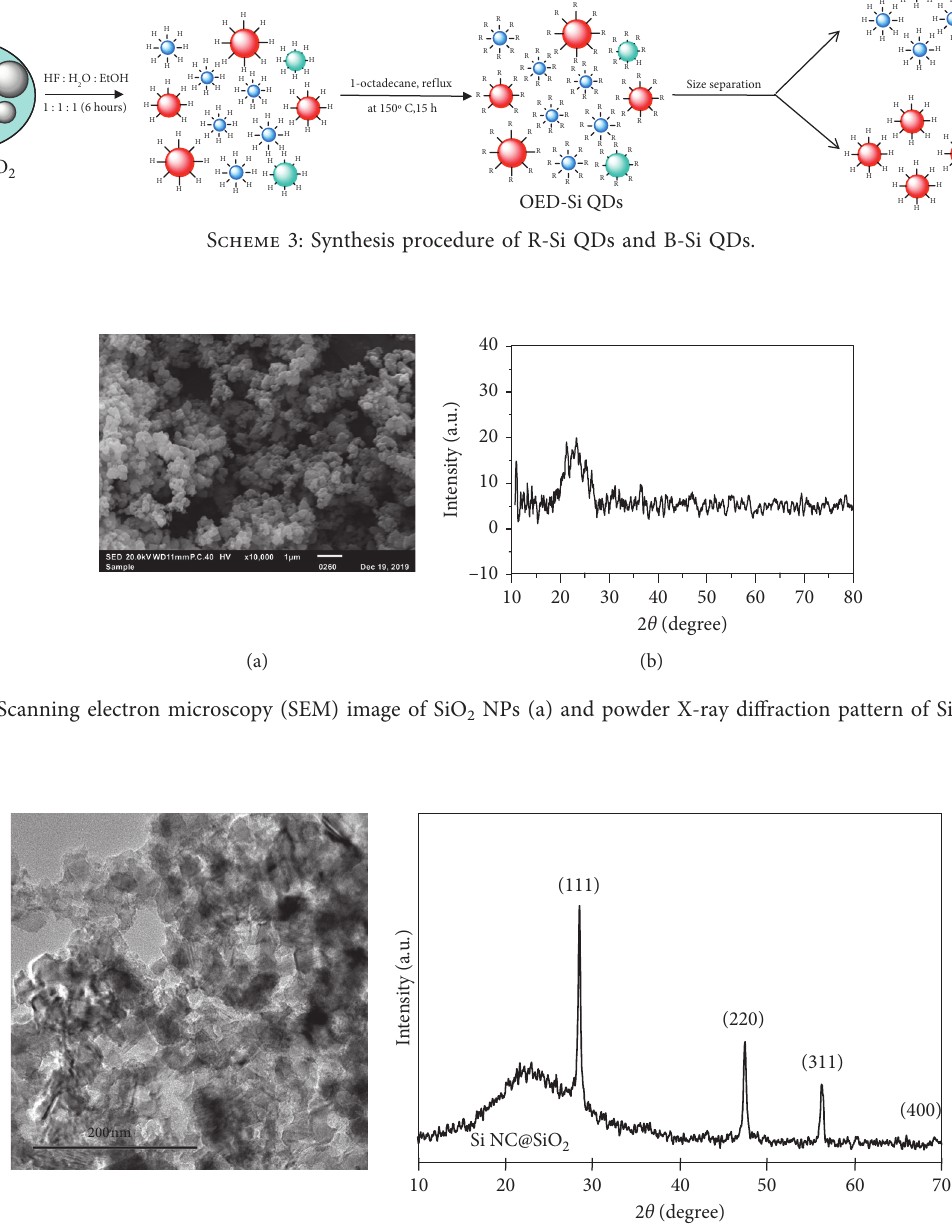
2 (a) and powder X-ray diffraction pattern of Si NC@SiO 2